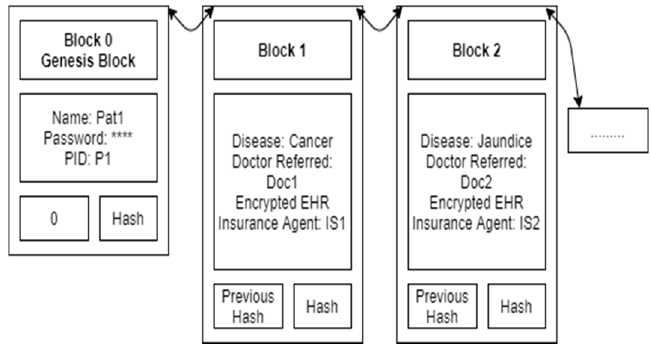
Figure 2. Patient Pat1 blockchain.